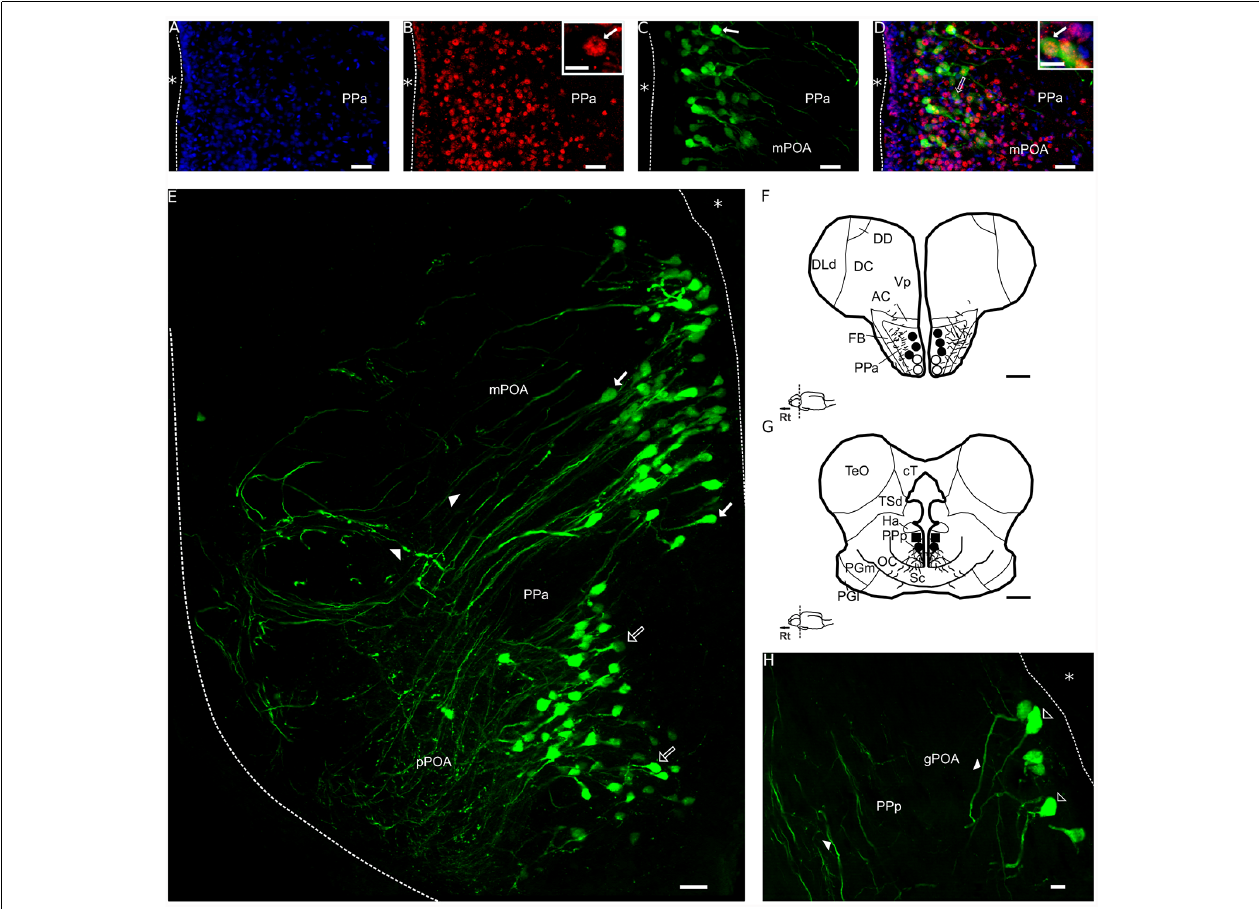
FIGURE 2 | Double immunolabeling for FOS and AVT in a transverse section of the POA of a social male of Brachyhypopomus gauderio . (A) Immunolabeling for DAPI (blue). (B) Immunolabeling for FOS (red). Inset in (B) : the arrow shows the nuclear label for FOS. (C) Immunolabeling for AVT (green). The arrow indicates an AVT+ cell. (D) Merge of (A–C) . Blank arrow indicates an AVT+ cell. Inset in (D) : the arrow shows a double-immunolabeled cell for FOS and AVT (yellow). (E) PPa section of the POA immunolabeled for AVT (false color green), blank arrows indicate pPOA cells and filled arrows indicate mPOA cells. Arrowheads indicate AVT+ fibers. (F,G) Diagrams of AVT+ cells; pPOA (dots), mPOA (black dots), gPOA (squares) and fibers (lines) in a rostral (F) and caudal (G) transverse sections. (H) PPp section of the POA immunolabeled for AVT (false color green). Blank arrowheads indicate gPOA cells somata and filled arrowheads indicate fibers. ∗ , ventricle all levels; Rt, rostral; AVT, vasotocin; pPOA, parvocells; mPOA, magnocells; gPOA, gigantocells; PPa, nucleus preopticus ventricularis, anterior subdivision; PPp, nucleus preopticus ventricularis, posterior subdivision; AC, anterior commissure; cT, tectal commissure; DC, central division of dorsal forebrain; DD, dorsal division of the dorsal forebrain; Dld, dorsolateral telencephalon, dorsal subdivision; FB, forebrain bundle; Ha, hypothalamus anterioris; OC, optic chiasm; PGl, preglomeriular nucleus, lateral subdivison; PGm, preglomerular nucleus, medial subdivison; nucleus; PPa, nucleus preopticus periventricularis, anterior subdivision;